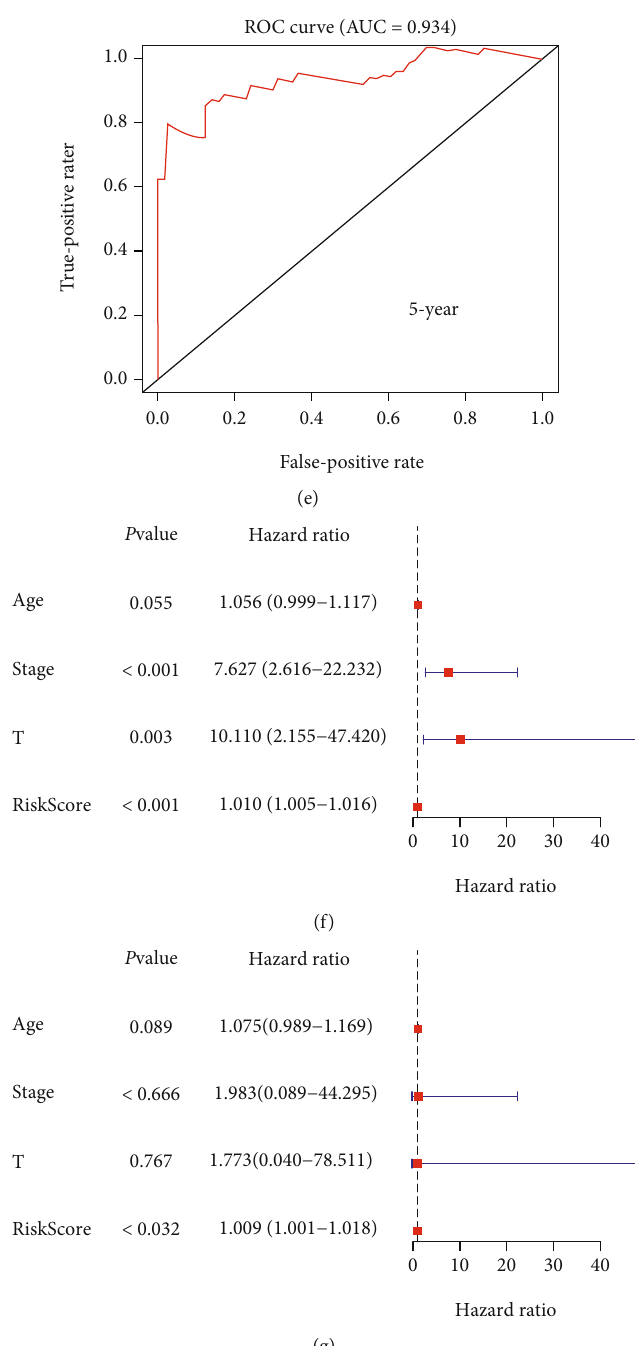
Figure 7: Risk signature in KICH and its correlation with clinical characteristics. (a – c) The process of building the risk signature containing six genes in KICH. (d) Survival curve drawn based on the model. (e) Five-year ROC curve. Results of (f) univariate Cox analysis and (g) multivariate Cox